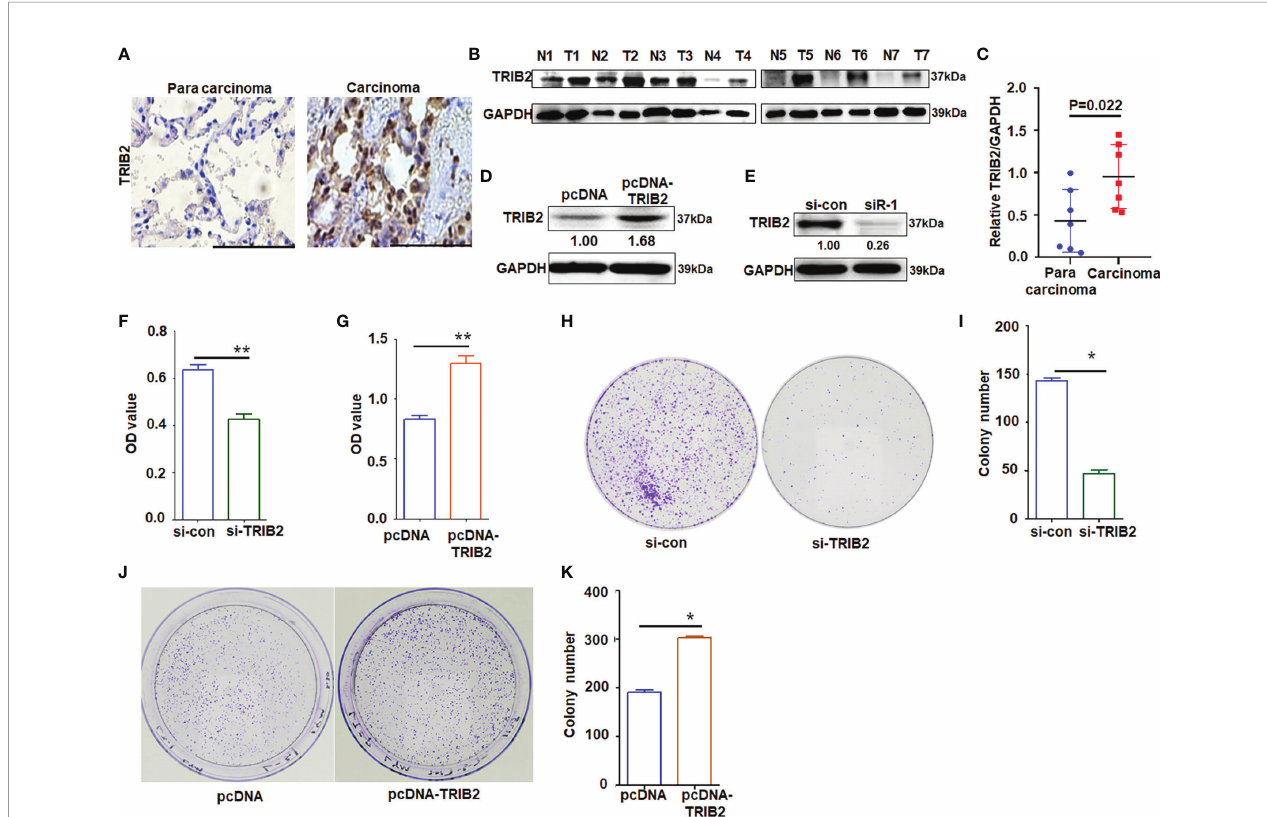
FIGURE 1 | Effects of TRIB2 on cancer cell proliferation. (A) Immunohistochemistry analysis of TRIB2 expression in one paired sample of lung anticarcinoma versus adjacent normal lung tissue; bar = 100 m m. (B) Total proteins from seven paired samples of lung adenocarcinoma ( T ) versus adjacent normal tissues ( N ) were extracted for Western blotting analysis with antibodies against TRIB2. (C) The levels of TRIB2 in seven lung adenocarcinoma and paired normal lung tissues of (B) was quanti fi ed with Image J (NIH, Bethesda, MD, USA) software and normalized to GAPDH, data were expressed as median (interquartile range). (D, E) TRIB2 expression in A549 cells treated with pcDNA-TRIB2 or TRIB2-siRNA and controls was assessed by Western blotting. GAPDH was used as the loading control. (F) TRIB2-siRNA inhibits A549 cell viability by MTT assay following siRNA transfection for 48 h Data represent the mean ± SD; for triplicate experiments. ** p < 0.01; LSD test. (G) Overexpression of TRIB2 increases viability of A549 cells by MTT assay. Data represent the mean ± SD; for triplicate experiments. ** p < 0.01; LSD test. (H, I) Knocking down TRIB2 inhibits colony formation of A549 cells. Data represent the mean ± SD; for triplicate experiments. * p < 0.05; LSD test. (J, K) Overexpression of TRIB2 increased colony formation of A549 cells. Data represent the mean ± SD; for triplicate experiments. * p < 0.05; LSD